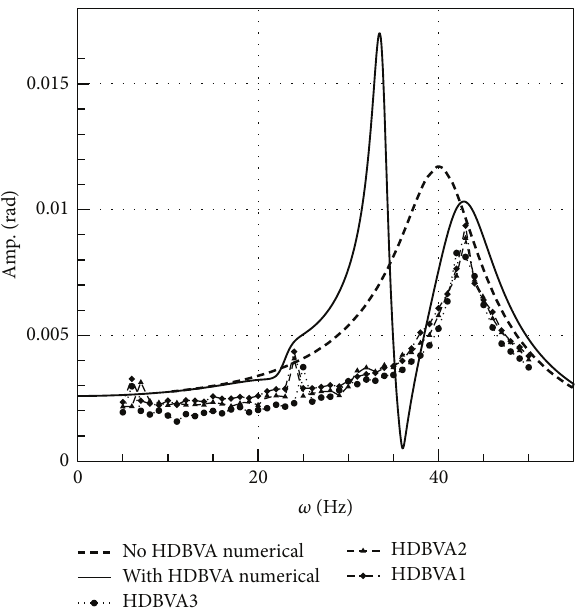
Figure 25: Frequency response of 𝜃 𝑌 DOF of case Figure 10(a), HDBVAs start at the far-from-force point.